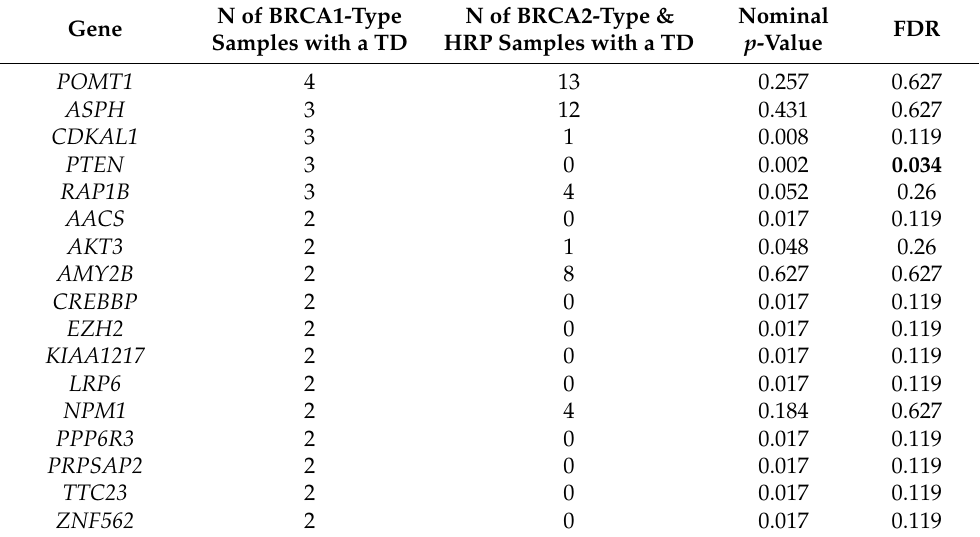
Table 1. Genes recurrently affected by a TD in BRCA1-type BC. The FDR is calculated using the Hochberg